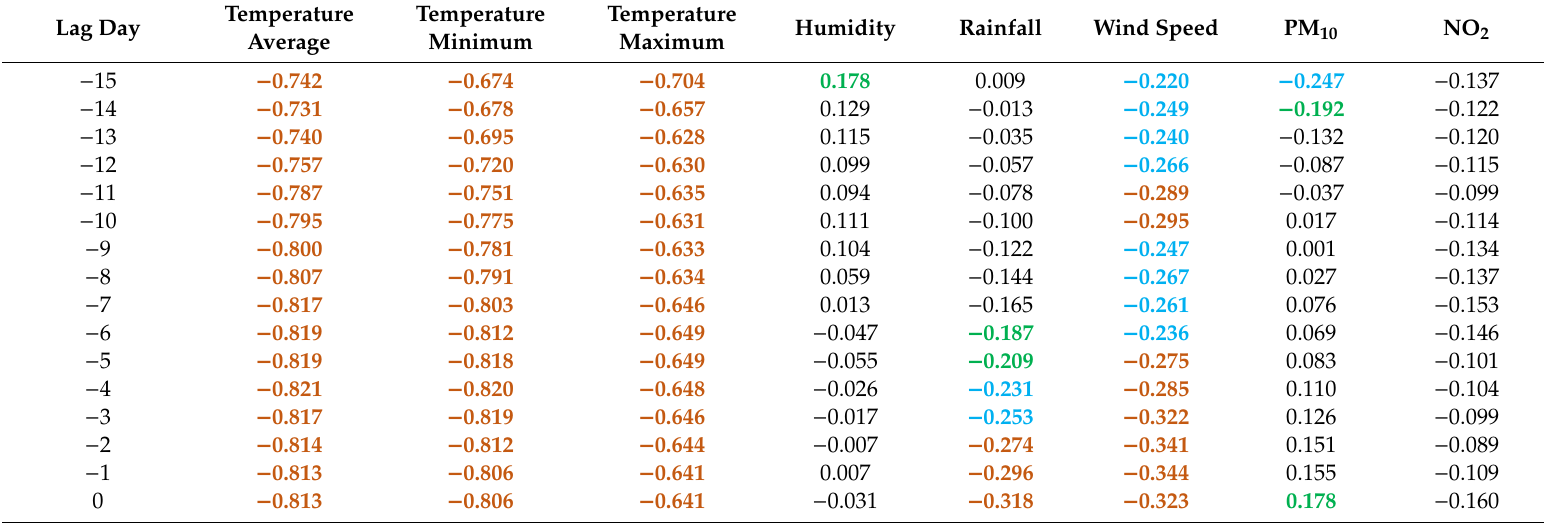
Table A3. Empirical results through Spearman rank correlation test for total cases in CABA, from lag of 15 days prior to the confirmation date (lag 0). Number colors indicate stands for 1% , 5% , and 10% level of significance,